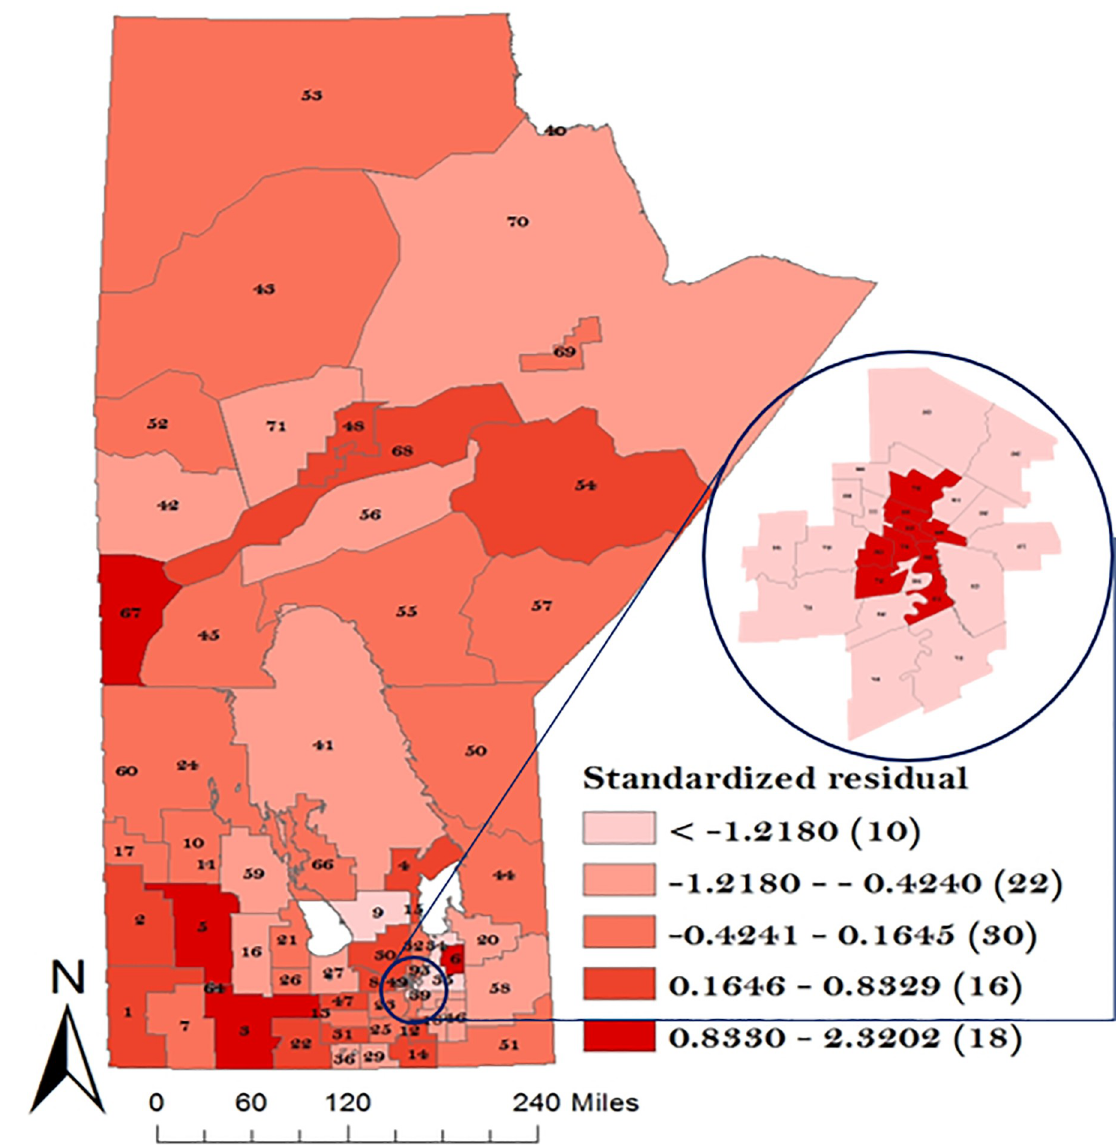
Fig 6. Map of unexplained variation in overall GC incidence risk ratio. Numbers in the map are the district labels from 1 to 96. Number of districts in each risk category is shown in parenthesis in the legend.